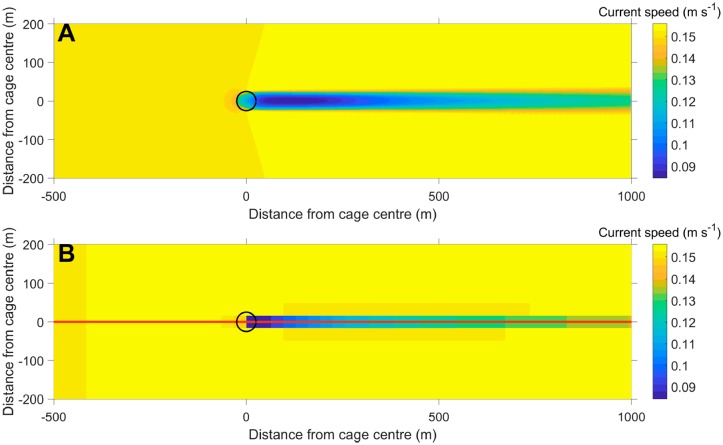
Wakes of salmon net pens.Comparison of the 10 m depth horizontal cross sections of the wakes of a circular salmon net pen (of diameter 50 m, 25 m deep, indicated by black circles) simulated by FLUENT ® (A) and SINMOD (B). The red line in B indicates the cross section used in the comparison of the CFD and ocean models and the parametrization of the drag coefficient (Fig 6, Eq (5)).